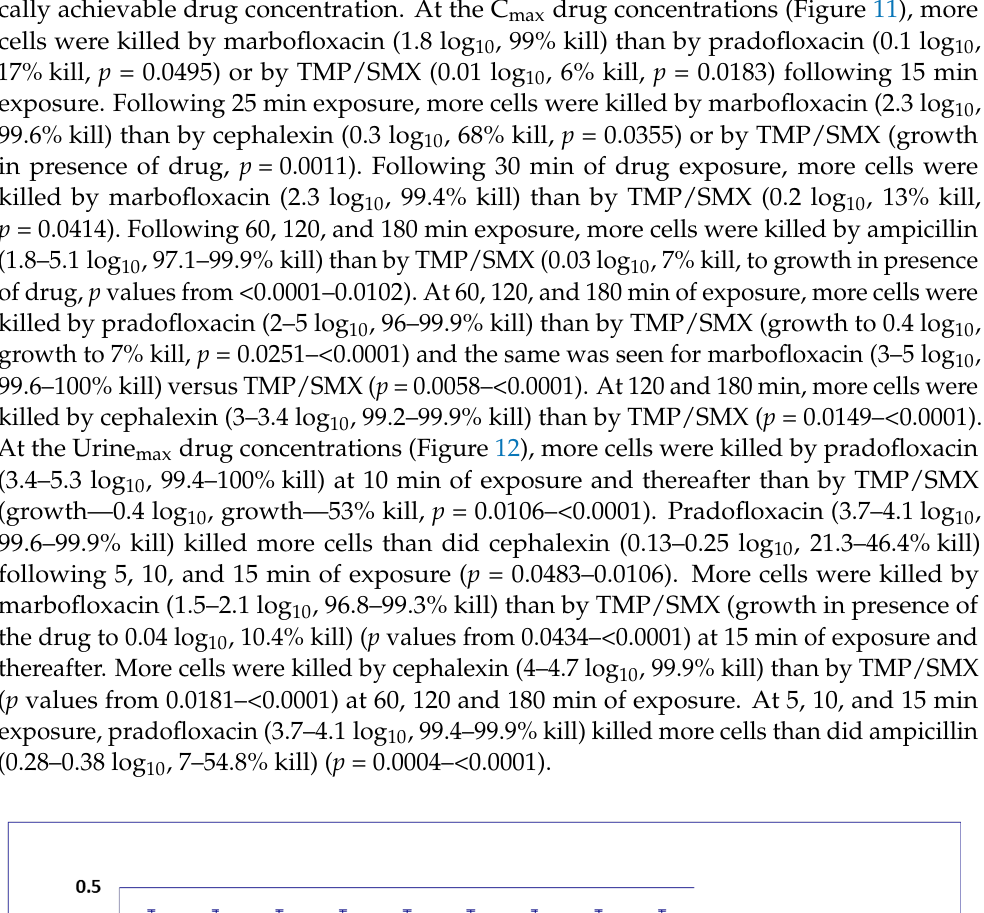
Figure 5. Log 10 reduction in E. faecalis with bacterial cells exposed to ampicillin, cephalexin, mar- bofloxacin, pradofloxacin, and trimethoprim/sulfamethoxazole at the minimum inhibitory drug concentration. Data points present mean ± standard deviation.